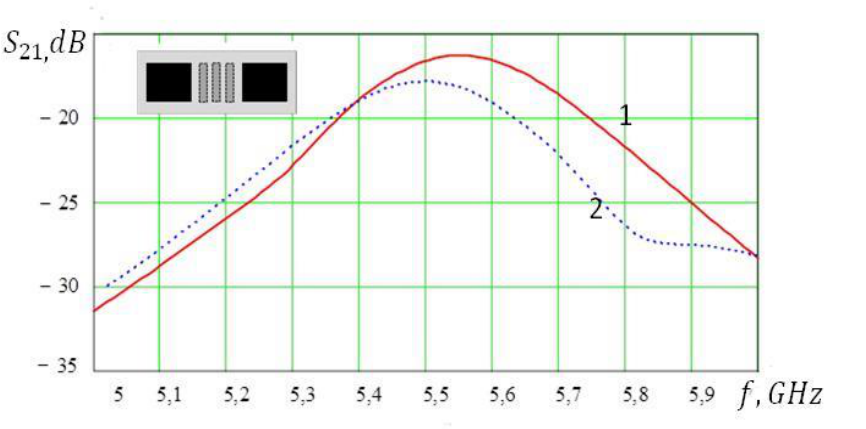
Fig. 4. Three slots in the ground plane: 1 – reference antenna; 2 – antenna with slots. Internal fields in microstrip antennas cou ld be changed by using “defected” substrates with any inhomogeneities in the dielectric material. One of the simplest of such inhomogeneities are the slots in substrate. Three kinds of slots were investigated (Fig. 5). Simulation results show that most applicable is the substrate with complicated slot in the form of meander cutout (Fig. 5, c).